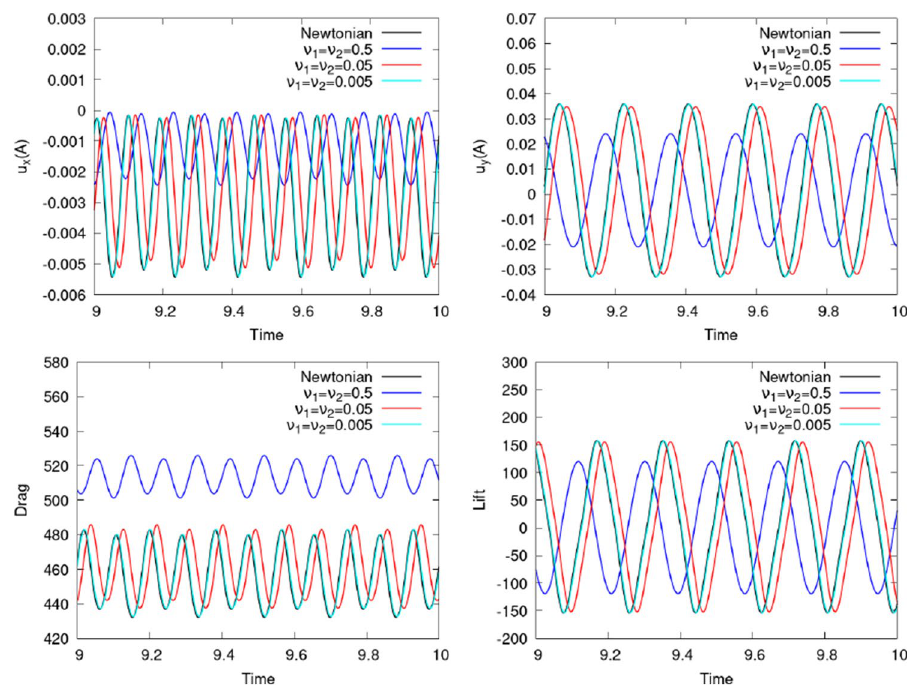
Fig. 9 Plots of the functionals for the Newtonian FSI3 case and three viscoelastic cases with with varying viscosities